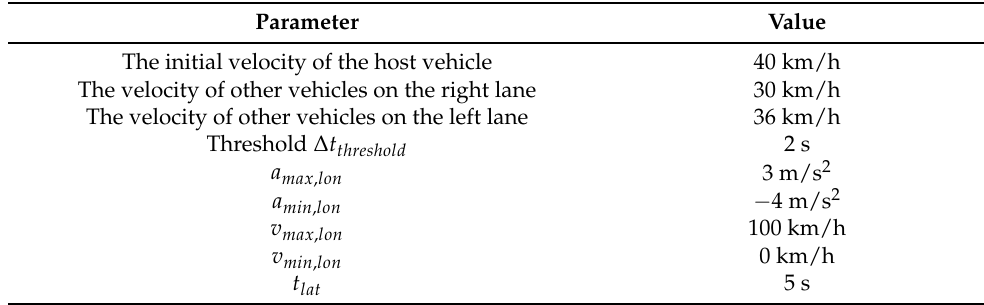
Table 2. The simulation configuration.